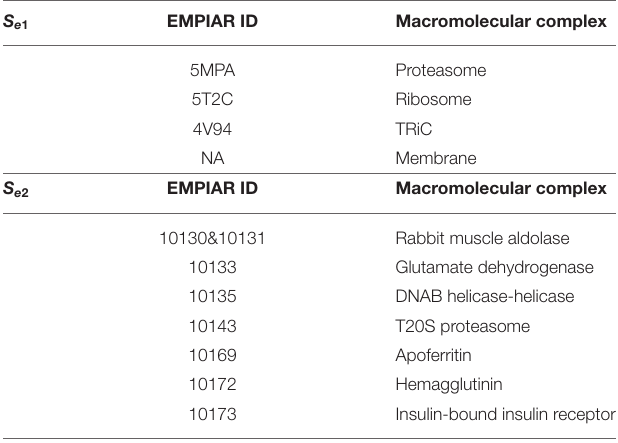
TABLE 1 | For domain S , we use two datasets for training S e 1 and S e 2 separately, which contains four classes subtomograms and seven classes subtomograms, with 400 images in each